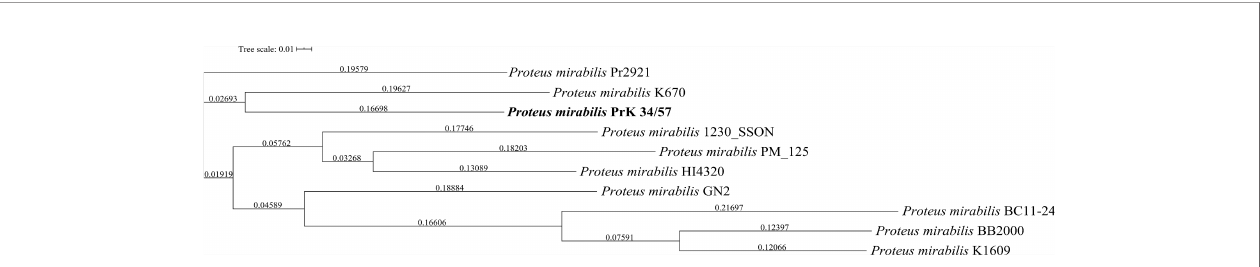
FIGURE 2 | Whole genome phylogeny of Proteus mirabilis strains based on single nucleotide polymorphisms (SNPs) using CSI Phylogeny webserver. The sequence of studied P. mirabilis PrK 34/57 strain is indicated by bold font. The obtained Newick fi le was visualized using Interactive Tree Of Life (iTOL) version 5.